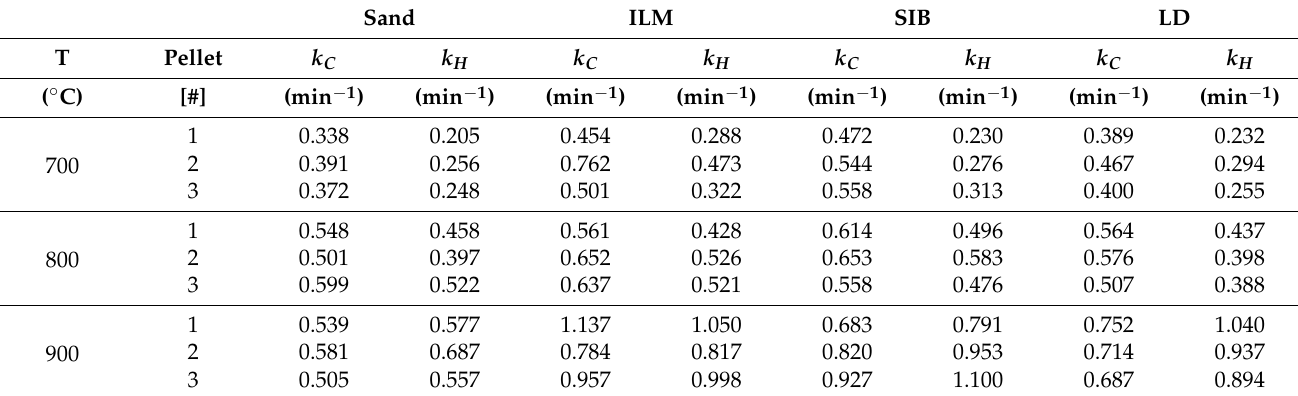
Table A3. Kinetic constants k C and k H obtained according to Section 2.4 and Appendix A for WSP.